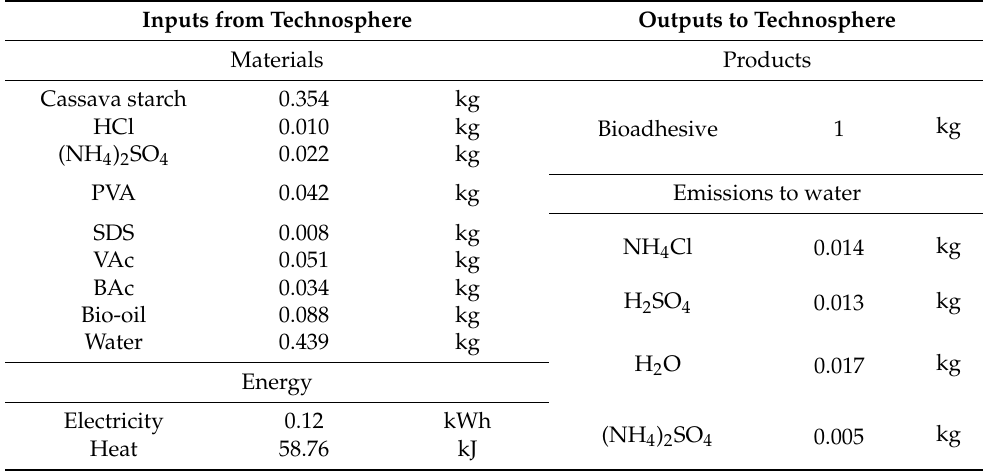
Inventory data for the production of hydrolyzed starch bioadhesive with bio-oil (Alternative 1). Detailed data per functional unit (1 kg of bioadhesive). Acronyms: polyvinyl